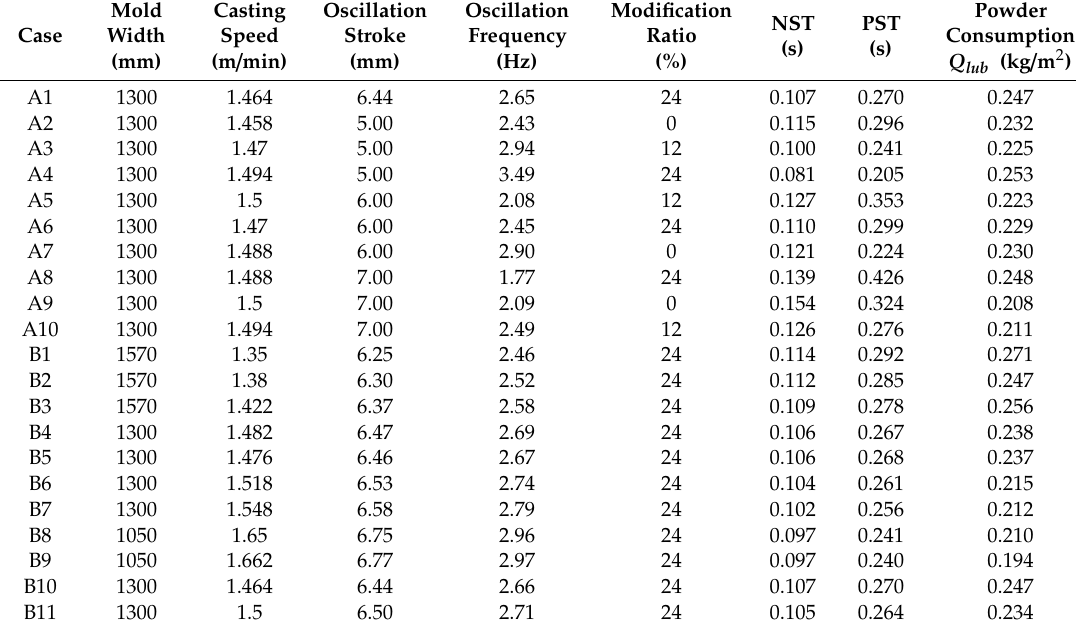
Table 1. Operating conditions from plant trials (Shin et al. [2]).